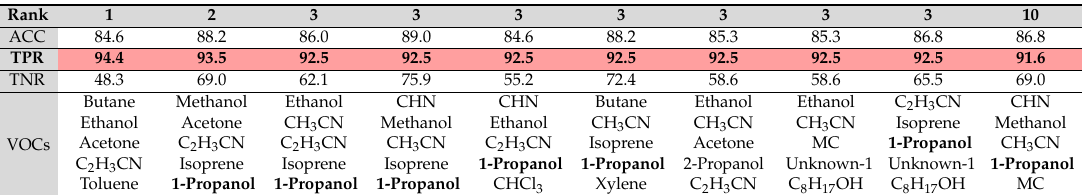
Table 3. Top 10 VOC combinations sorted by TPR (%) (5 VOCs were trained, MC = methylcyclohexane; boldface: most frequent VOC).